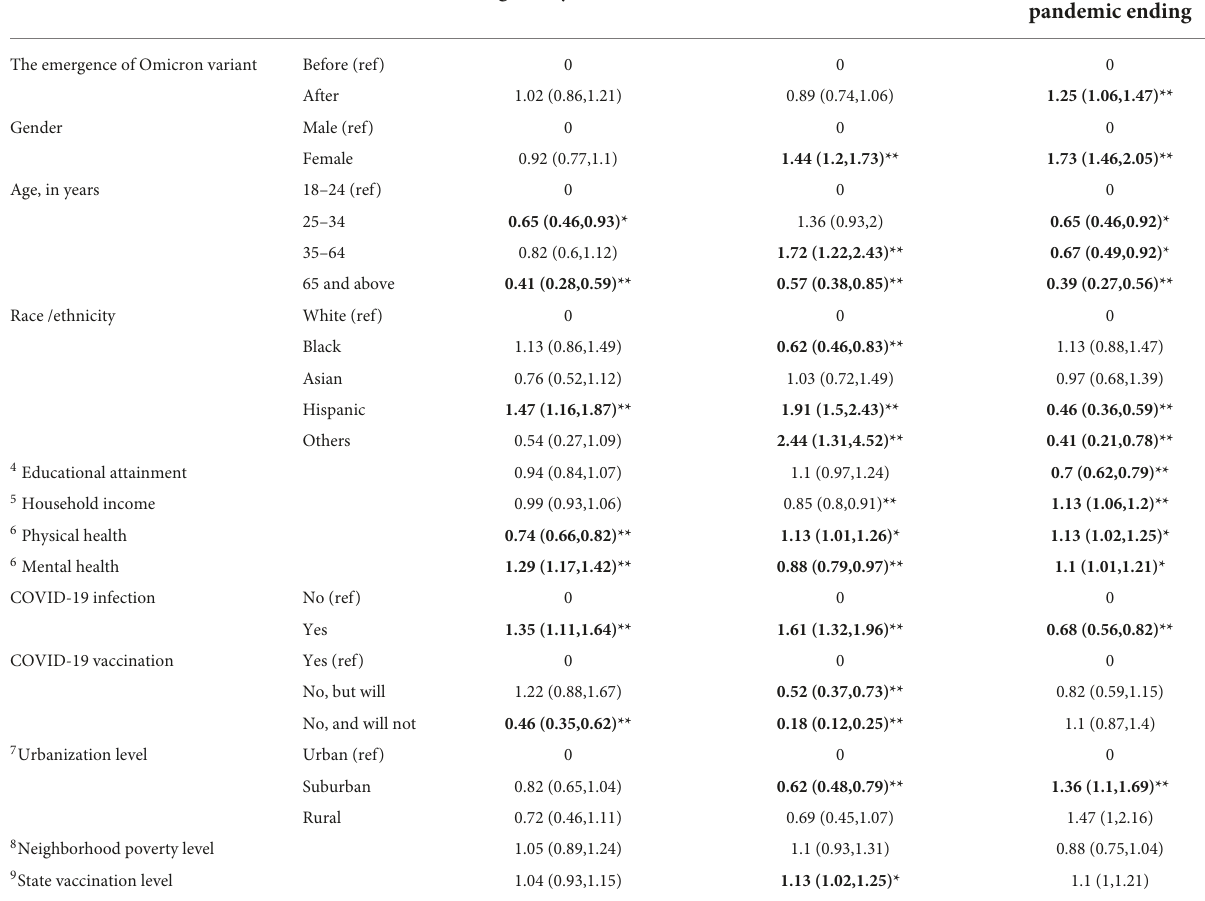
TABLE 4 Results of logistic regression models for the associations between variables with the three perception outcomes. 1 Negatively influenced 2 Worried about